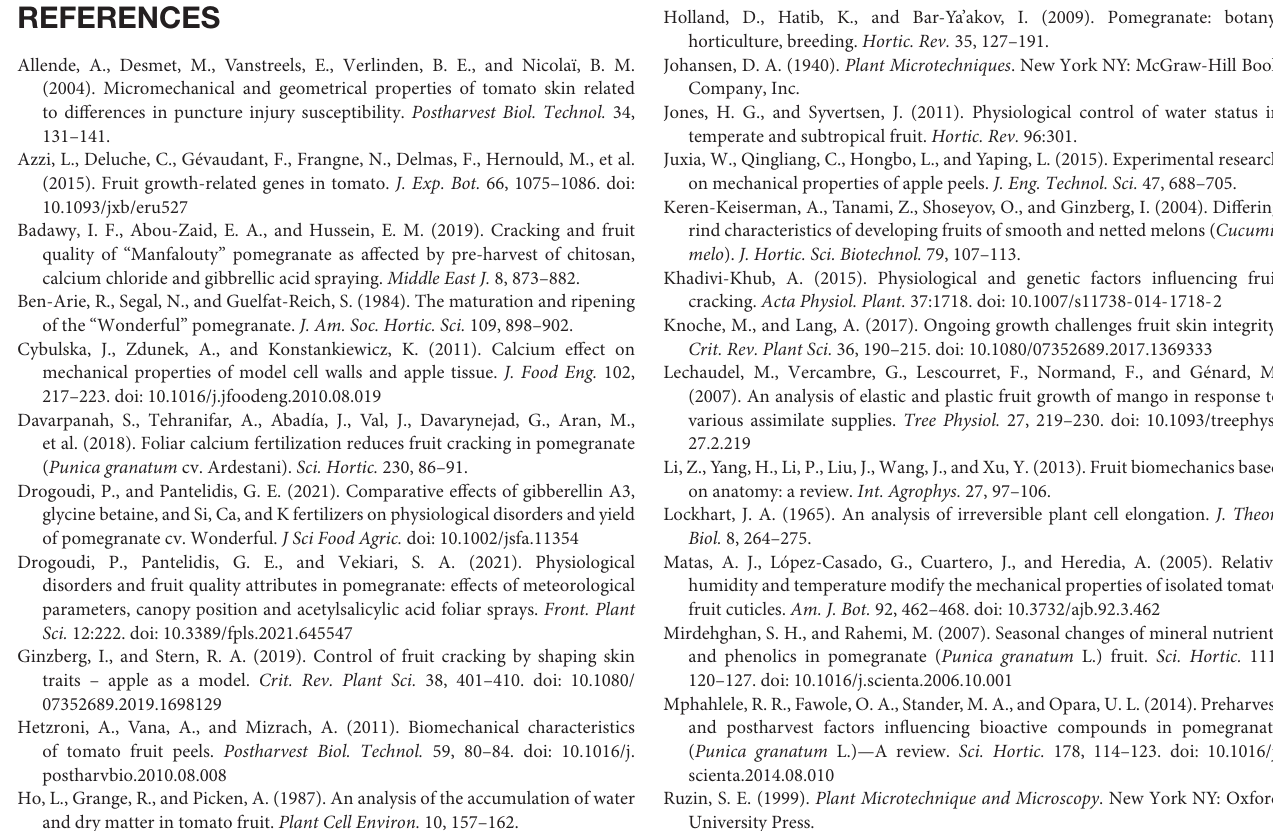
Supplementary Figure 4 | Maximum (red) and minimum (blue) temperatures and %RH (green) in the regions of orchard T (upper panel) and orchard S (lower panel) in June–October of the years 2015–2019. Data were provided by the meteorological services of the Ministry of Agriculture and Rural Development, Israel. Temperature range of 30–35 ◦ C is highlighted in light orange, and the period of July–August is highlighted in light blue. Note on the Y -axis that temperatures in the region of orchard S are higher than in the region of orchard T. Number of days with high temperatures and low humidity during July–August are given in Table 1 in the main text. Supplementary Figure 5 | Association between number of days with temperatures higher than 34 ◦ C (blue), or average minimum humidity (%RH; orange) during July–August, and the percentage of fruit bigger than 650 g in the respective years. Data are given for orchards S (2015–2018) and T (2016–2018) based on Table 1 in the main text. Trend lines are given with R 2 -values. Supplementary Figure 6 | Pomegranate skin observed by light microscope. Micrographs were taken at 4–6, 8, 11–15, and 24 weeks after full bloom (orchard H, year 2014). Each micrograph was selected from three independent fruit, and represents skin anatomy at the specified sampling time. A yellow line outlines the epidermal layer, and arrows point to the cuticular layer. Bar = 100 µ m. Supplementary Figure 7 | Epidermal cell density in pomegranate skin during the growing seasons of 2015 and 2016 in orchards S and T, respectively. The number of epidermal cells in histological sections was counted along a 1-mm line. Values are averages of three replicate fruit ± SE. Data were analyzed for statistical significance by Student’s t -test. Mean values with different letters differ significantly at P < 0.05. Supplementary Figure 8 | Elasticity of pomegranate peel during 2016 growing season showing data from orchards T and S. Data from each orchard and time point are an average of 5 fruit with ±